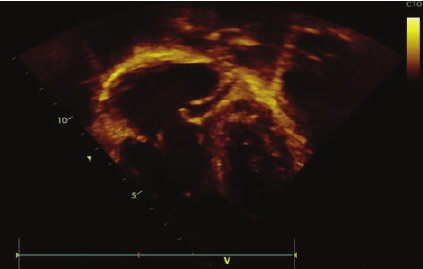
Figure 4: Floating tricuspid valve leaflet and damaged (ruptured) tricuspid valve